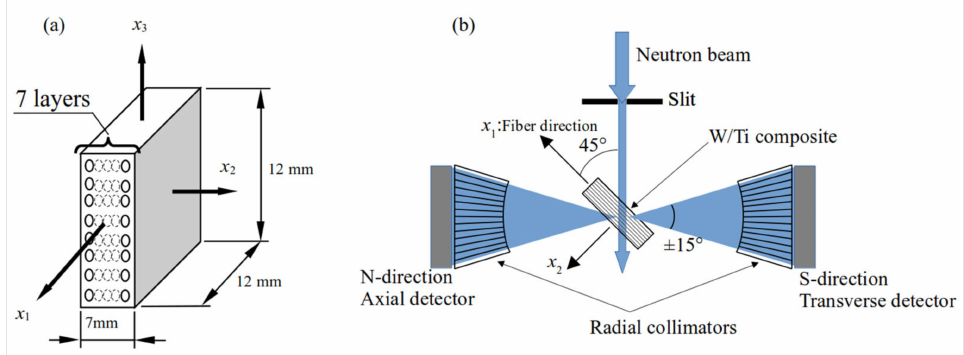
Figure 3. Schematic diagram of ( a ) coordinate system of W/Ti composite, and ( b ) sample setting and neutron measurement